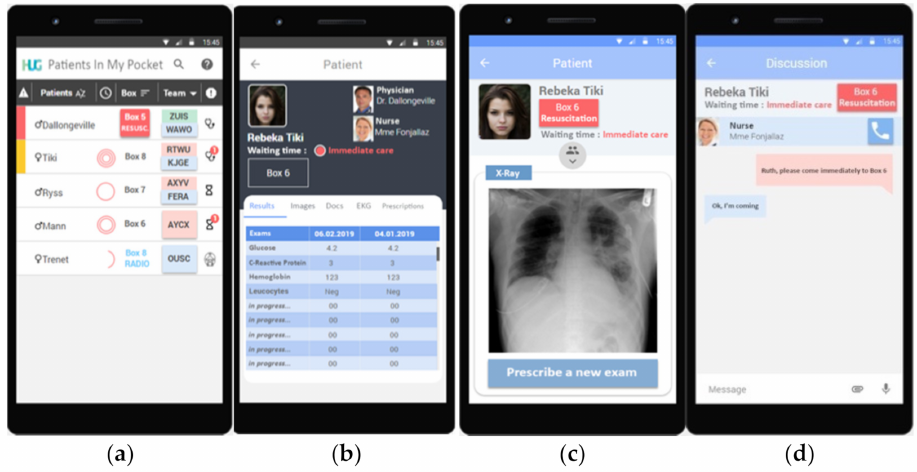
Figure 1. PIMPmyHospital screenshots. ( a ) Color-coded bars represent patient status on the five- level Canadian Triage and Acuity Scale [31]; patient gender and identity; time since admission as radial circular timers; patient allocation per room; color-coded box of individuals in charge of the patient; and patient status (seen by a physician, waiting for results, CT-scan in progress, etc.). Push notifications prompt the user to be aware of the situations. ( b , c ) Selecting a patient opens a new page with scrollable contextual tab menus containing information related to laboratory results, imaging, patient files, electrocardiograms, and prescriptions entered in the computerized institutional prescription software. ( d ) The instant messaging system. The logos at the bottom of the screen represent the possibility to also import and link documents to the conversion as well as to send voice memos. Adapted from